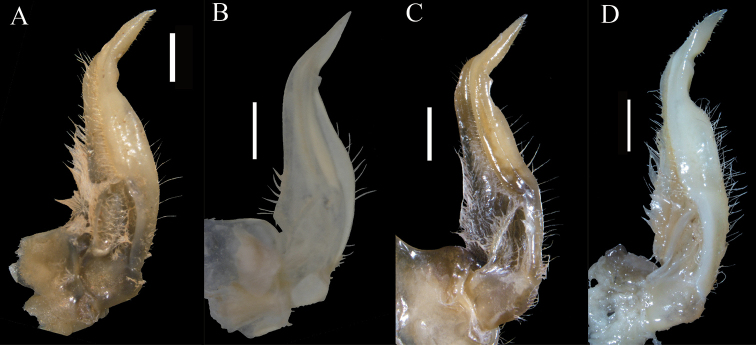
The ventral view of left G1 AEosamon
daiae sp. nov. holotype, male, 26.6 × 22.2 mm, NNU 190503 BEosamon
tumidum, male, 23.2 × 18.7 mm, IZCAS CB11382 CEosamon
lushuiense, male, 23.7 × 19.9 mm, NNU 162821 DEosamon
tengchongense, male, 37.9 × 30.1 mm, NNU 193261. Scale bars: 1.0 mm.